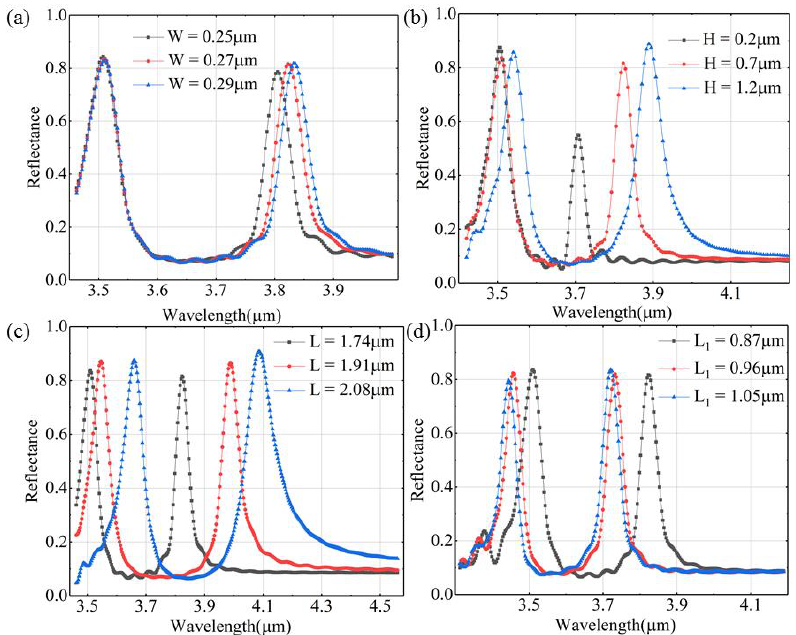
Figure 3. Reflectance spectra of different unit-cell geometrical parameters: ( a ) W ; ( b ) H ; ( c ) L ; ( d ) L 1 .